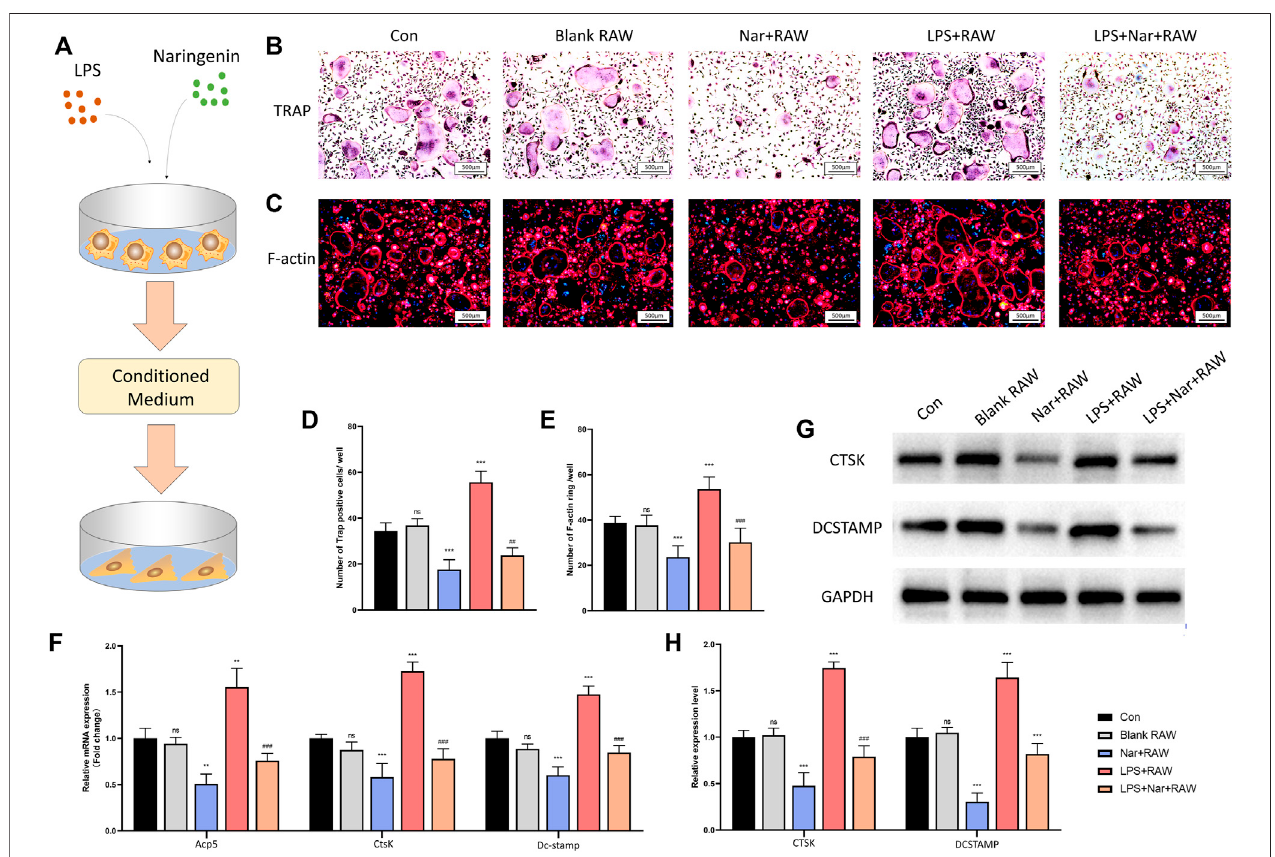
FIGURE 6| Osteoclastogenesis issuppressed under naringenin-modulated macrophage coculture medium. (A) Schematic illustration. (B,D) Formation of TRAP- positive cells and its quanti fi cation. (C,E) Formation of F-actin rings and its quanti fi cation. (F) Transcript levels of osteoblast markers Acp5, CtsK, and Dc-stamp. (G, H) Western blot and optical density analysis of CTSK and DCSTAMP with GAPDH as reference. n = 4 per group. Data are expressed as mean ± SD. * # p < 0.05; ** ## p < 0.01; *** ### p < 0.001. * compared with con group; # compared with LPS + RAW group.